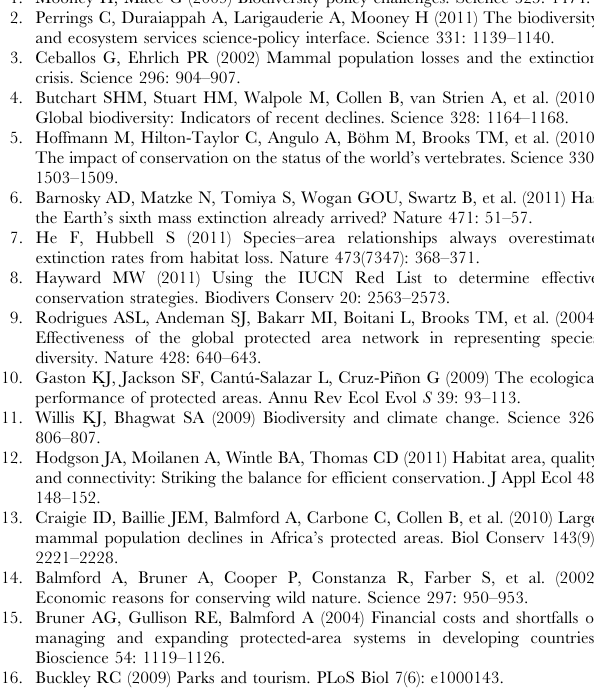
area budgets, by